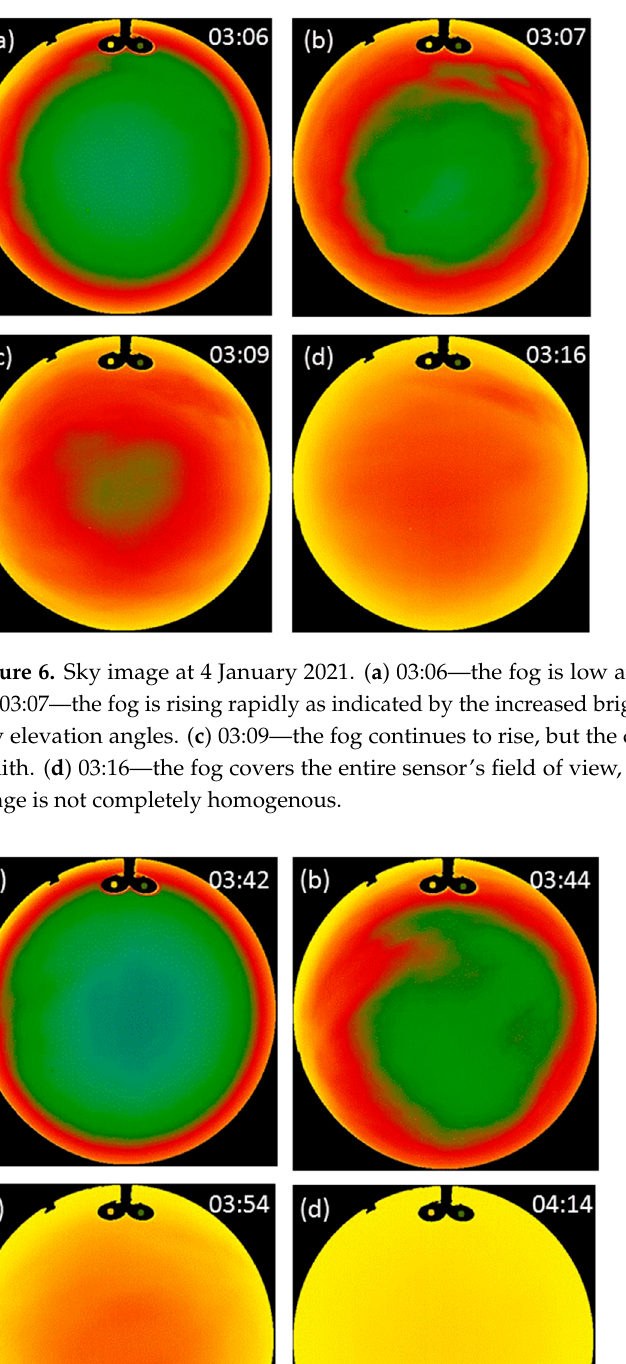
Figure 8. Sky image on 6 January 2021. ( a ) 09:57—Fully developed dense fog. ( b ) 10:03—the fog begins to dissipate. Low-density patches are clearly visible. ( c ) 10:22—Snapshot in the middle of the